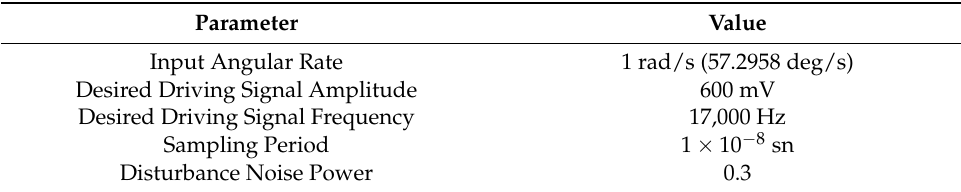
Table 3. Simulation Parameters.